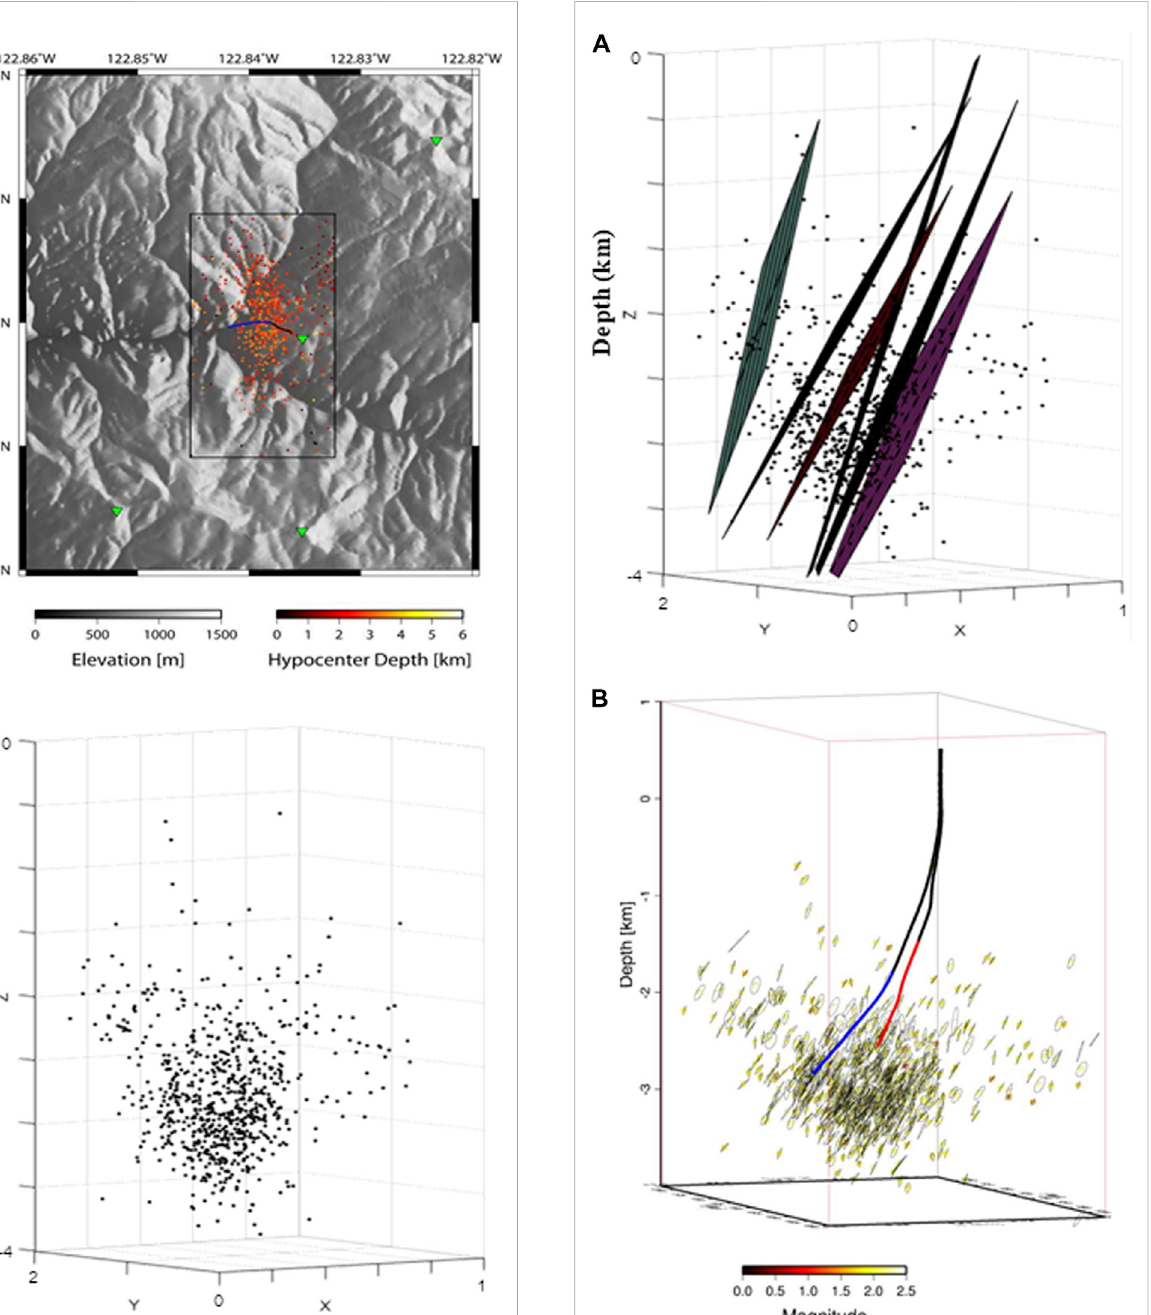
FIGURE 12 (A) Microseismic events detected by The Geysers broadband and geophone network in the vicinity near the injection site, adapted from Gritto et al. (2018). (B) Microseismic data were monitored by 34 permanent and 33 temporary geophones; 752 microseismic events were evaluated.